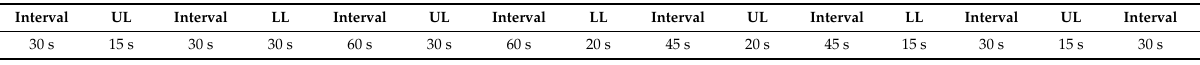
Table 2. Characteristics of a single series of alternate pulsating